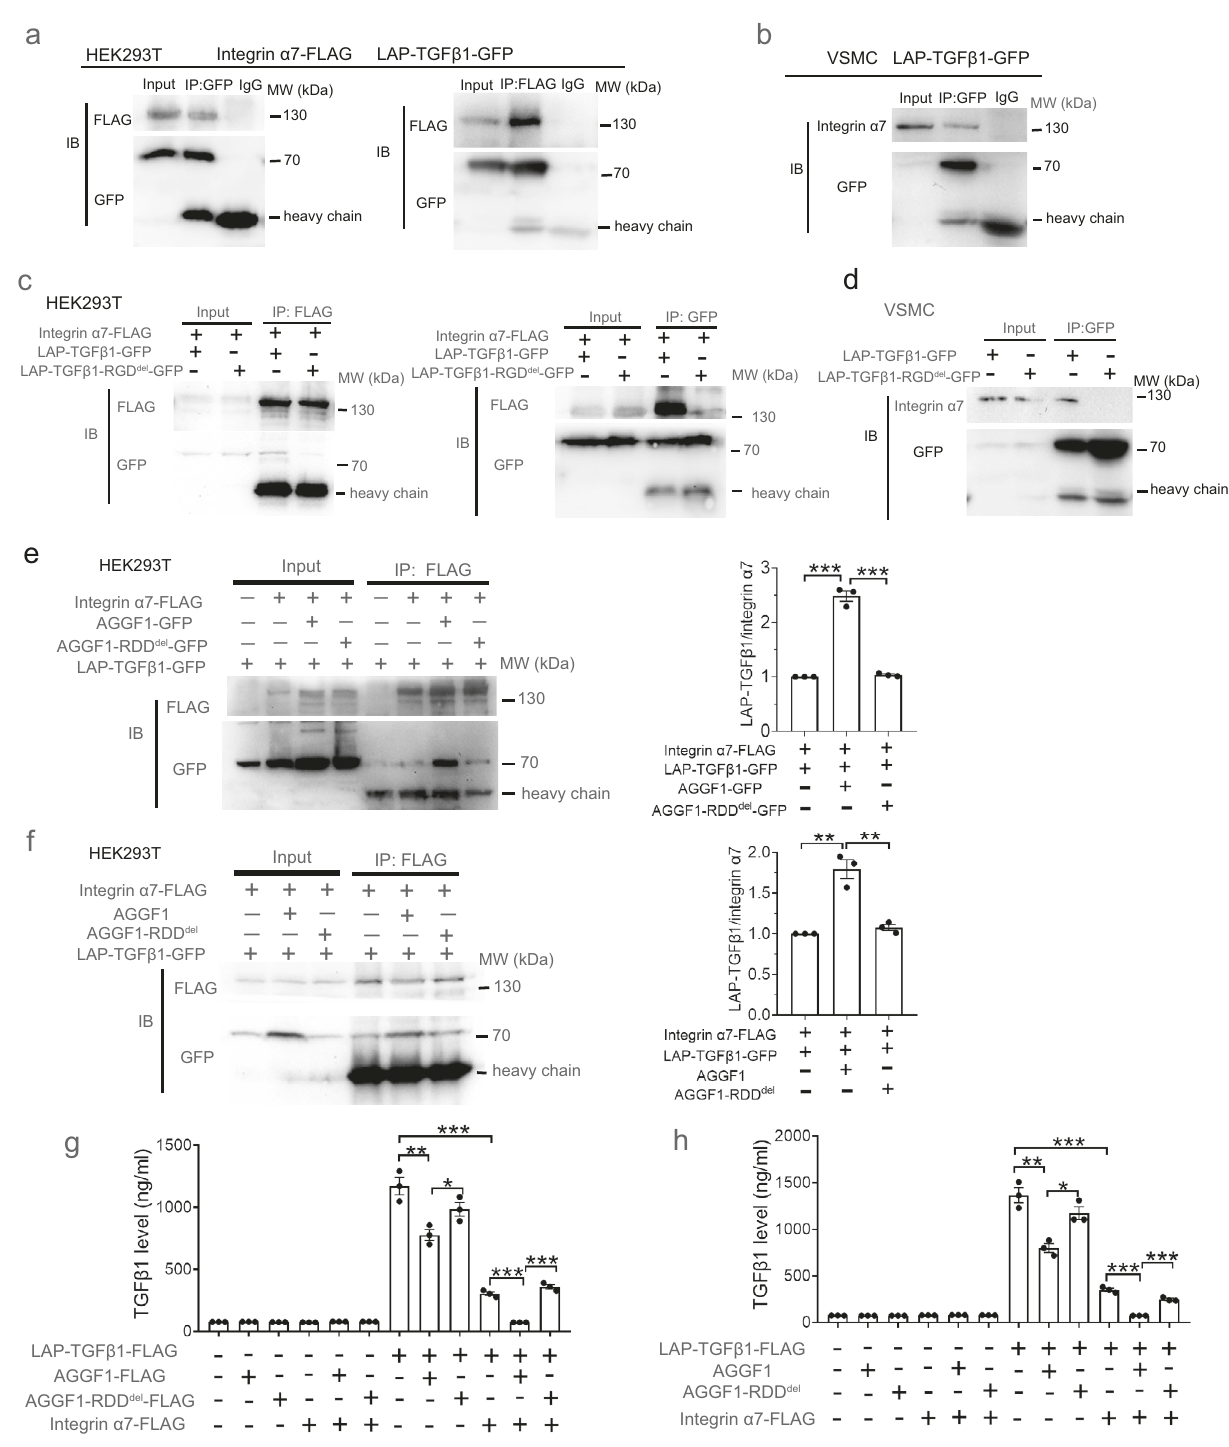
Fig. 6 | Integrin α 7 interacts with LAP-TGF- β 1 through the RGD sequence and AGGF1 enhances the interaction. a Co-IP using HEK293T cells with over- expression of LAP-TGF- β 1-GFP and integrin α 7-FLAG. b Co-IP for LAP-TGF- β 1 and endogenous integrin α 7 using VSMCs with overexpression of LAP-TGF- β 1-GFP. c Co-IPusingHEK293Twithoverexpressionofwild-typeLAP-TGF- β 1-GFPormutant LAP-TGF- β 1-RGD del -GFP together with integrin α 7-FLAG. d Co-IP using VSMCs with overexpression of LAP-TGF- β 1-GFP or LAP-TGF- β 1-RGD del -GFP. e Co-IP using HEK293T with overexpression of LAP-TGF- β 1-GFP, α 7-FLAG, wild- type AGGF1-GFP or mutant AGGF1-RDD del -GFP. The quanti fi ed data of the ratios of LAP-TGF- β 1-GFP/ α 7-FLAG are plotted on the right. f Co-IP using HEK293T with overexpression of